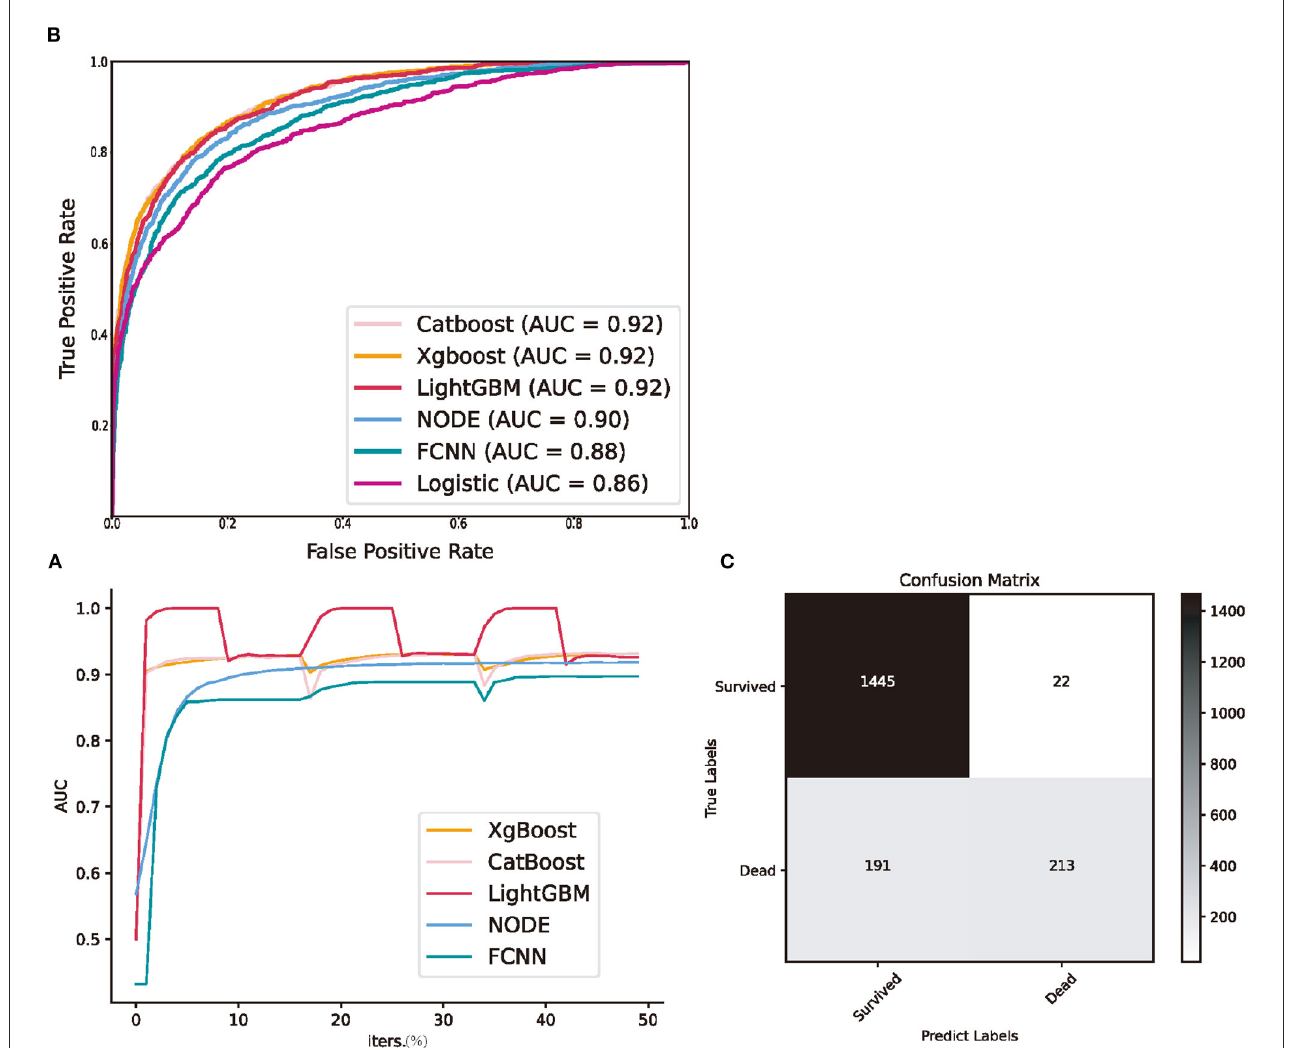
FIGURE2 Predictive performance of machine learning models in the testing set. (A) the validation area under receiver operating characteristic curve during three folds cross validation; (B) receiver operating characteristic curve of all machine learning models; (C) the confusion matrix of CatBoost. NODE, Neural Oblivious Decision Ensembles; FCNN, fully connected neural network; Logistic, logistic regression; AUC, area under receiver operating characteristic curve; iters.,